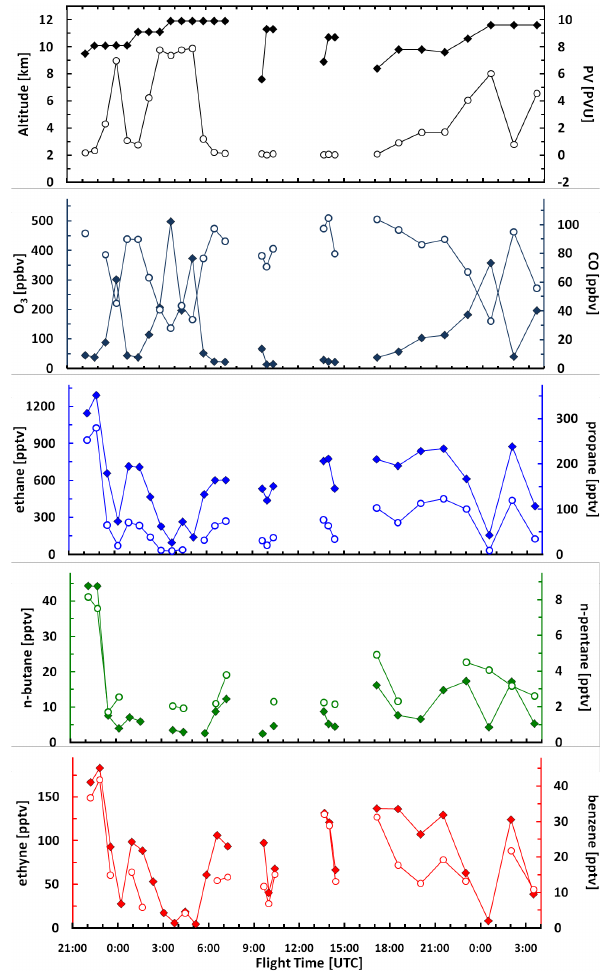
Fig. 4. Mixing ratios for select NMHC during a series of flights between Frankfurt, Guangzhou and Manila during February 2008 (see text for description). Closed diamonds refer to the scale on the left while open circles refer to the scale on the right of each plot. Samples collected through 08:00UTC are from the flight from Frankfurt and Guangzhou; samples collected between 09:30 and 15:30UTC are from the round trip flight between Guangzhou and Manila (3 on each leg); samples collected after 17:00UTC represent the return from Guangzhou to Frankfurt.